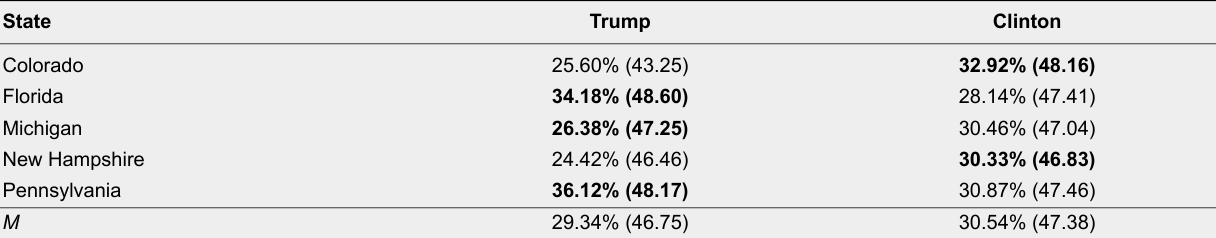
The Total Audience Response Time as a Proportion of Overall Speech Time Evoked by Each Candidate in Swing